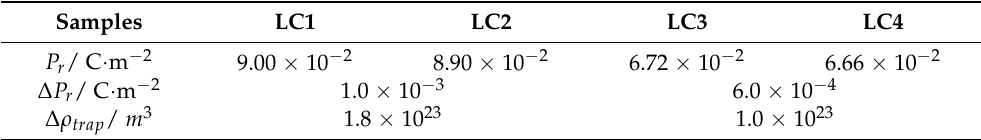
Table 2. The remnant polarization ( P r ), the change values of the remnant polarization ( ∆ P r ), and the change values of trapped charge density ( ∆ ρ trap ) for the LC1–LC4